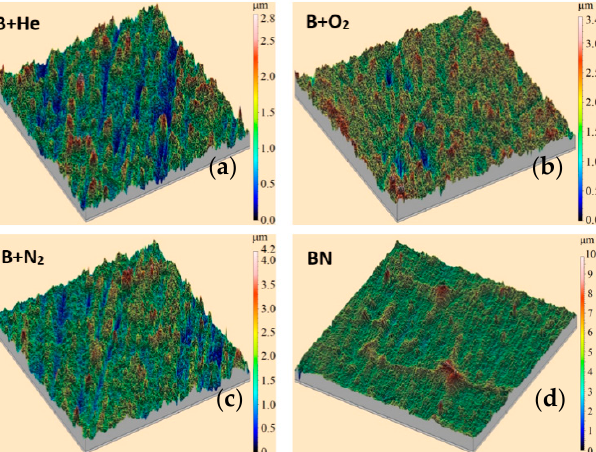
Figure 31. Three-dimensional profiles of the boron-based coatings synthesized during evaporation of boron in helium ( a ), oxygen ( b ), and nitrogen ( c ), and of boron nitride in the residual atmosphere ( d ) [139].